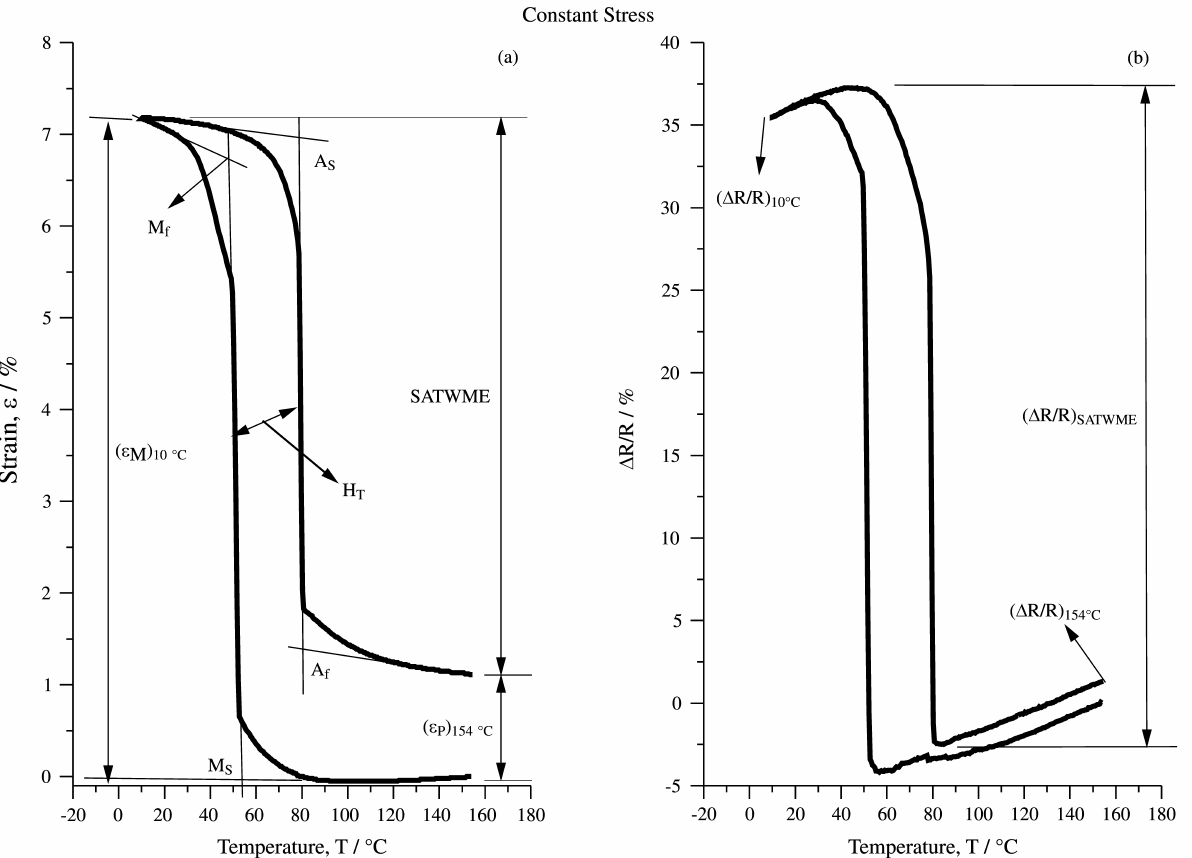
Figure 3. Representation of the (a) strain and (b) ER loops obtained during a typical test. The investigated parameters are pointed out on this